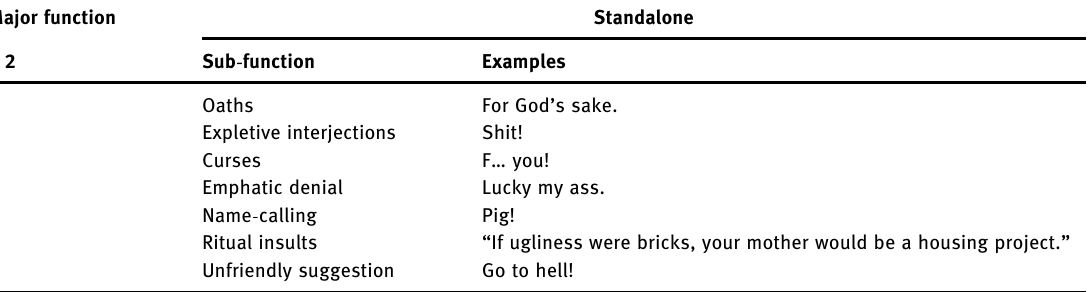
Table 2: Standalone function Major